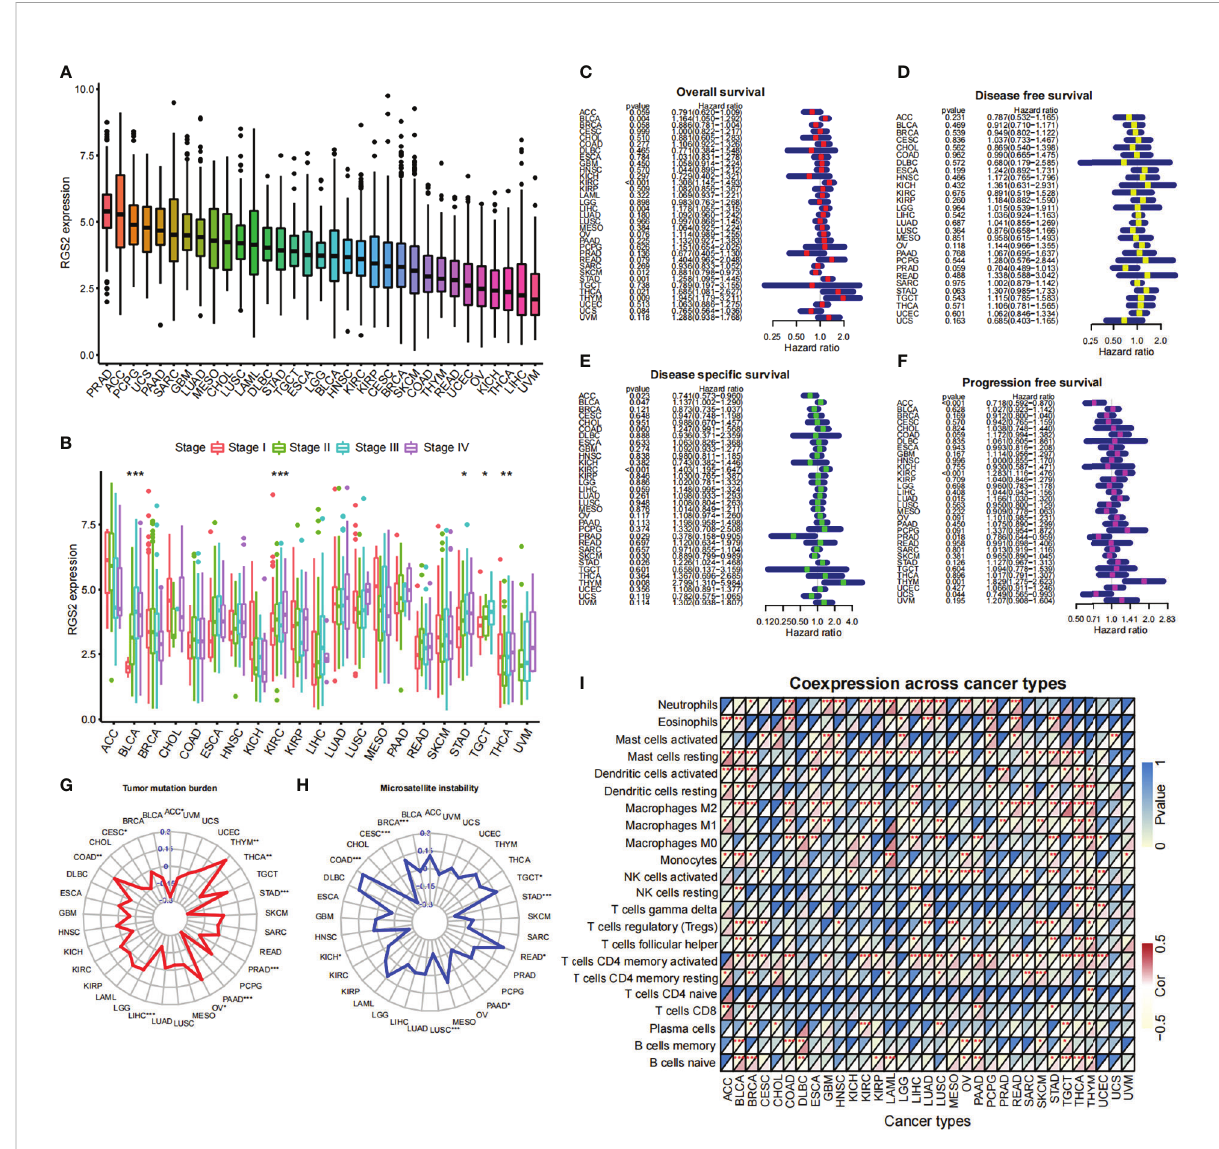
FIGURE 7 Biological signi fi cance of RGS2 in pan-cancer (A) RGS2 expression level in multiple tumors (B) Correlation analysis between RGS2 expression level and tumor stage (C) Relationship between RGS2 expression level and OS (D) Relationship between RGS2 expression level and disease-free survival (E) Relationship between RGS2 expression level and Disease speci fi c survival (F) Relationship between RGS2 expression level and Progression free survival (G) Correlation analysis between RGS2 and Tumor mutation burden (TMB) (H) Analysis of the correlation between RGS2 and Microsatellite instability (MSI) (I) The relationship between RGS2 and immune cell in fi ltration. *p<=0.05,